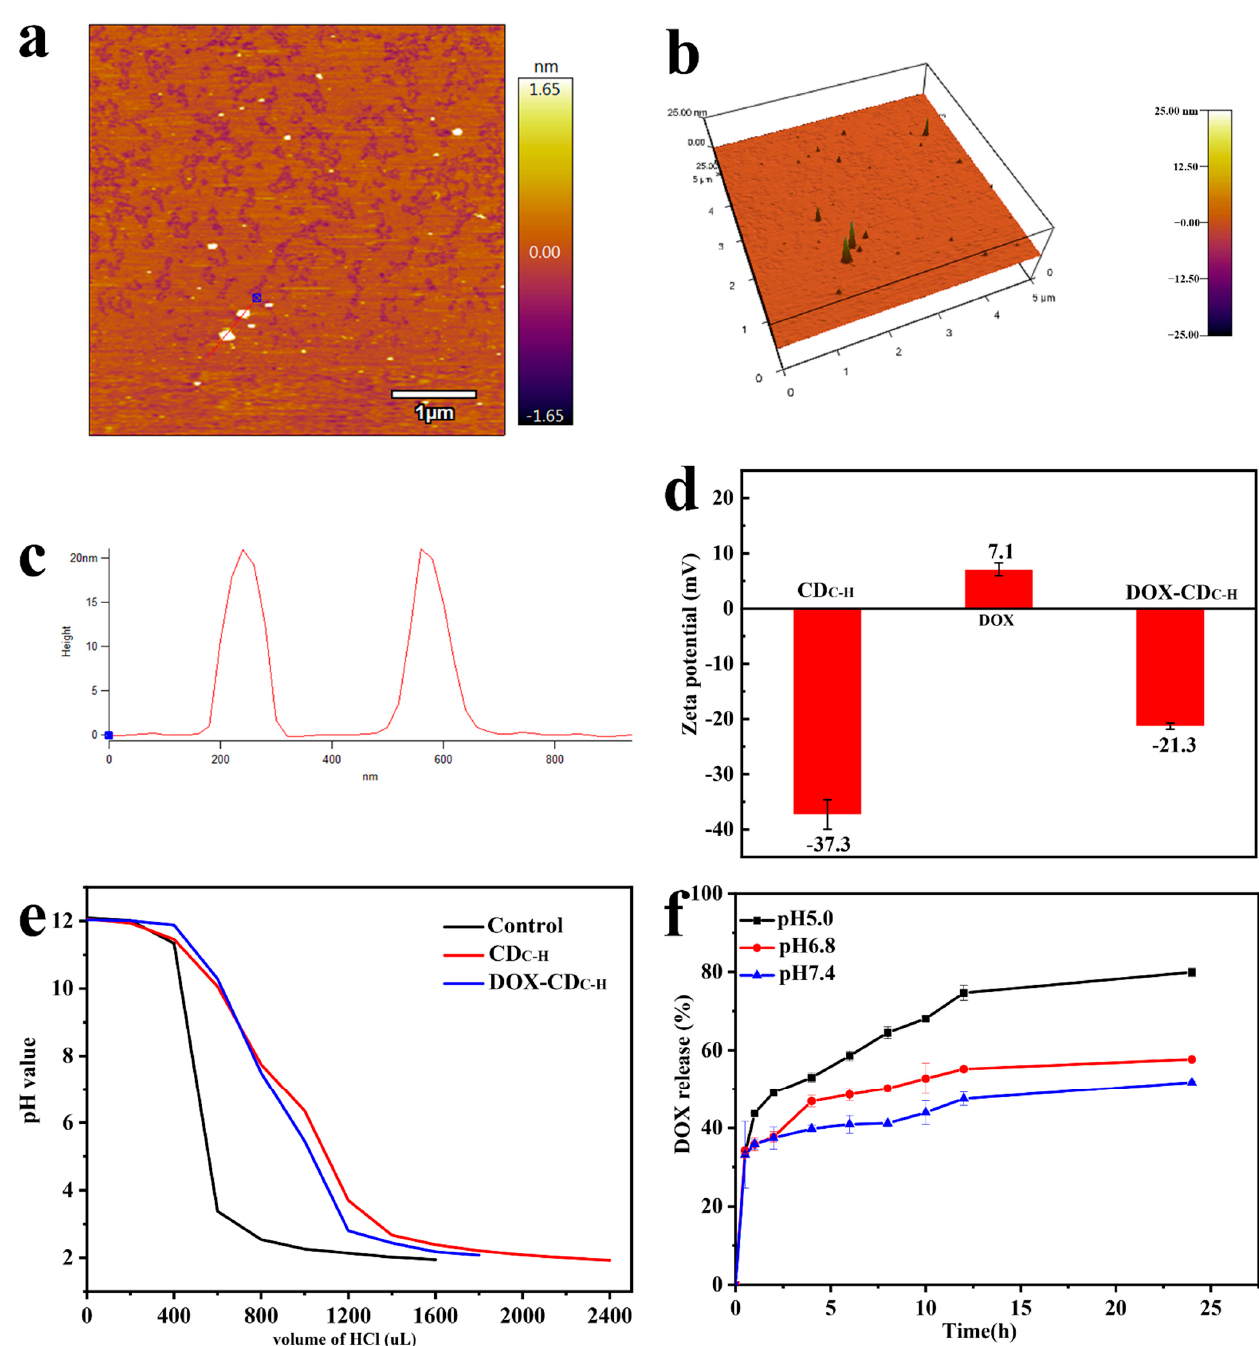
Figure 5. AFM topography image ( a ) and AFM 3D image ( b ) of DOX–CD C-H . Height profile along the line in AFM topography images of DOX–CD C-H ( c ); zeta potentials of different samples ( d ); acid–base titration profiles for samples ( e ); release profiles of DOX–CD C-H complexes in different pH media, values are mean ± SD, (n = 3) ( f ). Table 2. The kinetic model correlation coefficients (R 2 ) of the in vitro release curve.